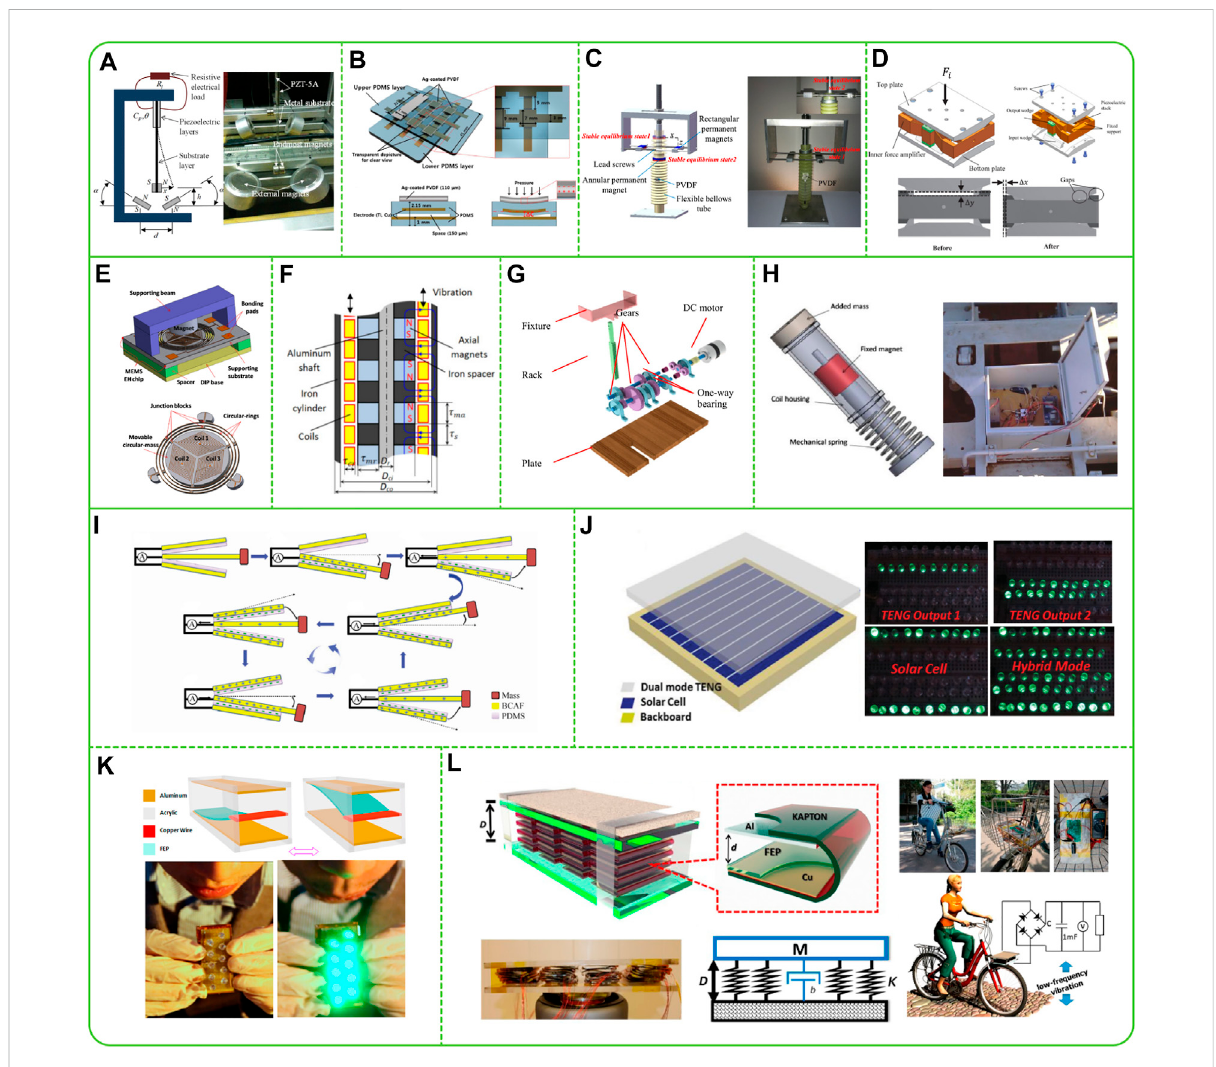
FIGURE 1 DifferentKEHtechnologiesfromtheambientenvironment. (A) Schematicdiagramandclose-upviewofBPEH(Zhouetal.,2013). (B) Schematic diagram of the fl exible energy harvester (Eun et al., 2014). (C) Schematic and prototype of NBEH (Deng et al., 2019). (D) Isometric, sectional and side views of the integrated multistage piezoelectric energy harvester (Wen and Xu, 2019). (E) Schematically drawing and perspective view of the 3D harvester (Liu et al., 2012). (F) Dimensions and parameters of LETs (Tang et al., 2014). (G) Design of the high-ef fi ciency electromagnetic energy harvester (Zhang X. et al., 2016). (H) Mechanical design and fi eld testphotograph of theelectromagnetic vibration converter (Bradai et al., 2018). (I) A cycle of the electricity generation process of the triple-cantilever based TENG (Yang et al., 2013a). (J) Schematic diagram of the as-fabricated hybridized power pane and the photograph of 50 commercial LED bulbs driven by the hybridized power pane (Zheng et al., 2015). (K) Schematic diagram of the TENG and the photograph showing that the proposed TENG was used to harvest the human mouth blowing induced wind energy (Yang Y. et al., 2013). (L) Schematic diagram, prototype, detailed structure, equivalent mechanical model, and fi eld test photograph of the elastic multiunit TENG (Wang et al.,